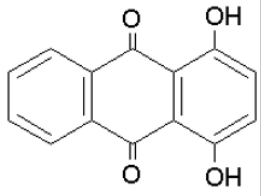
Figure 4. Structural formula of quinizarin.